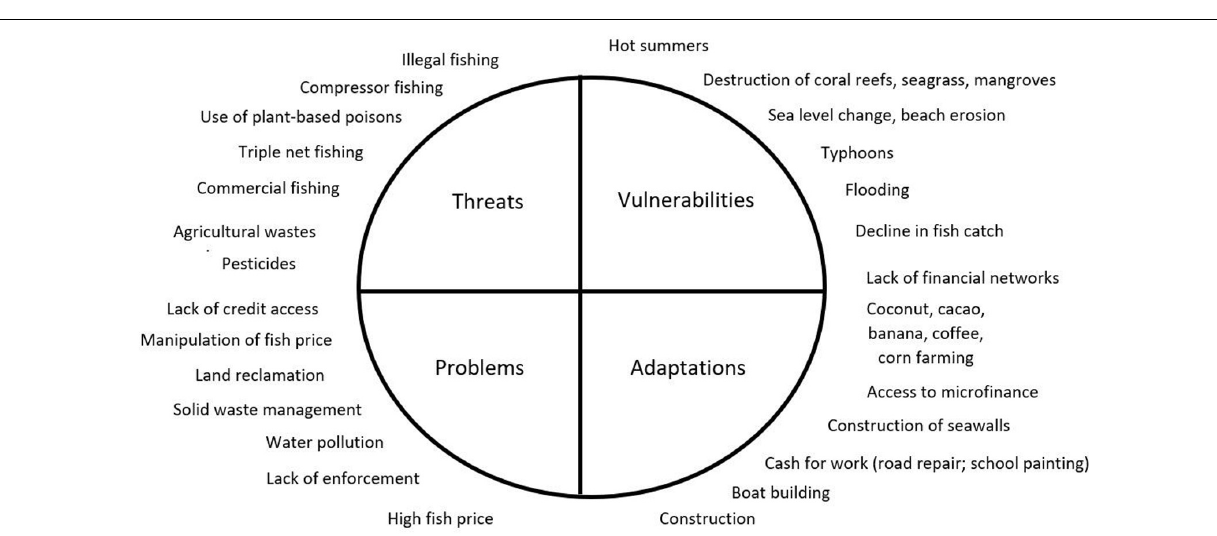
FIGURE 4 | Perceived threats, vulnerabilities, problems and adaptation strategies of fishers to climate change (based on